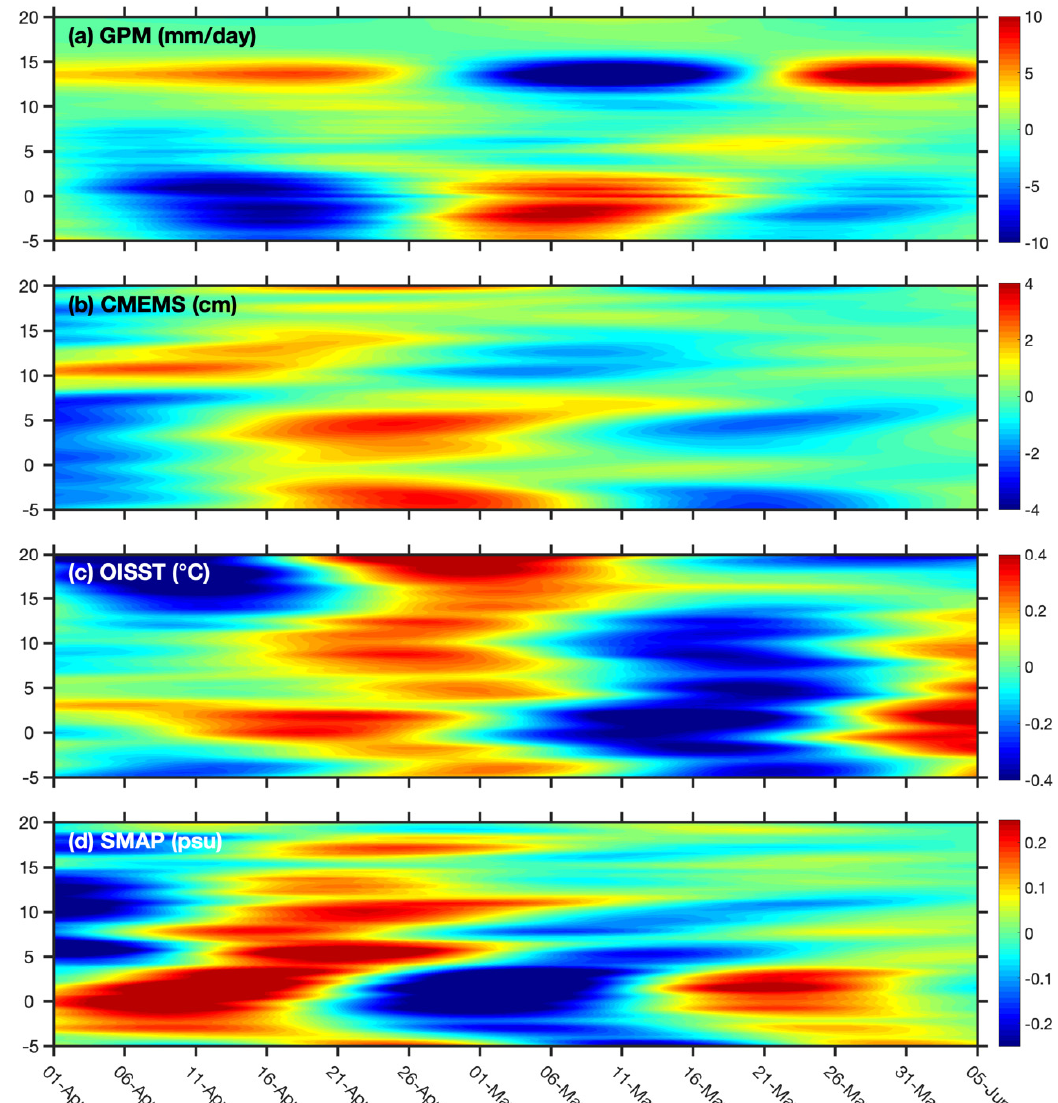
Figure 11. 30–90-day filtered time–latitude plots of ( a ) GPM precipitation rate (mm / day), ( b ) CMEMS SLA (cm), ( c ) OISST (°C), and ( d ) SMAP SSS (psu) in the southeastern Arabian Sea (65–70°E, − 5–20°N) from April 1 to May 31, 2020 with the seasonal cycle removed.